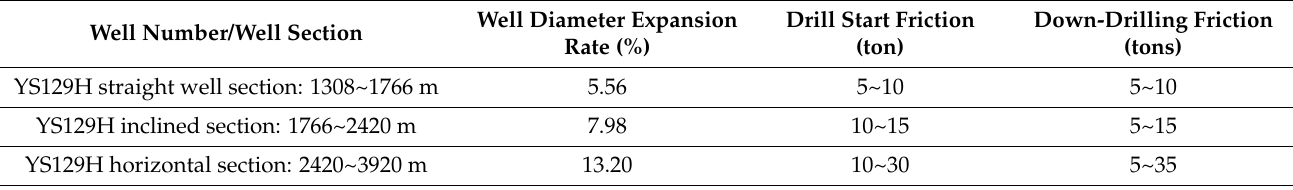
Table 6. Well diameter expansion rate and start-up and downhole friction in YS129H.